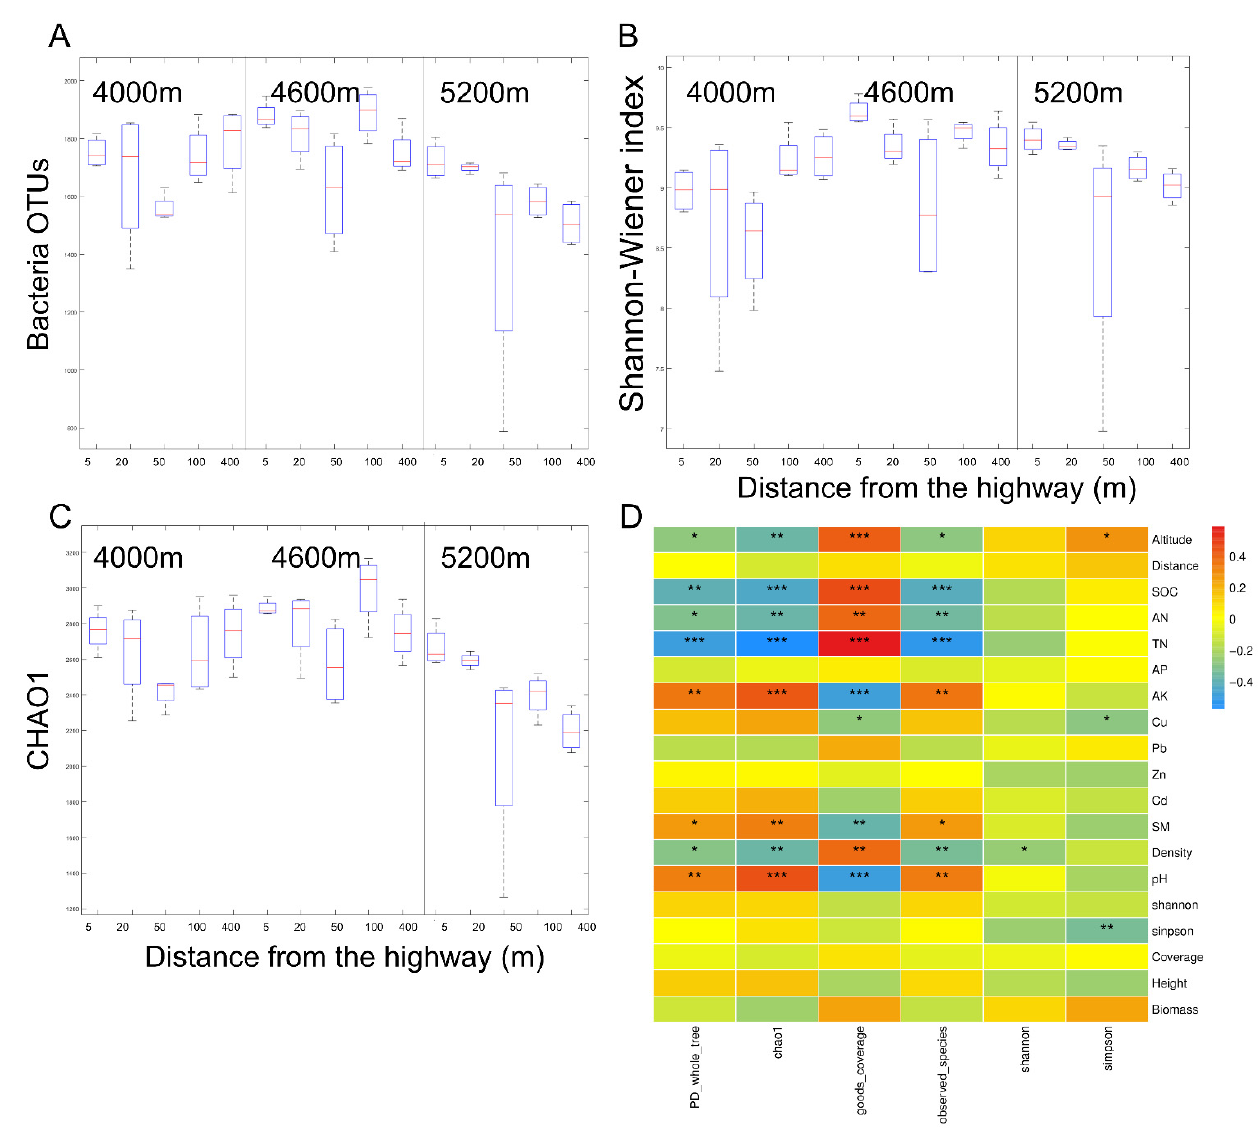
Figure 6. Box Diagram of ( A ) bacterial operational taxonomic unit (OTU), ( B ) bacterial Shannon and ( C ) bacterial CHAO1 in the 0–20 cm soil depths at 5, 20, 50, 100, and 400 m from G109 highway at altitudes of 4000 m (L), 4600 m, (M) and 5200 m (H). Pearson correlation heatmaps are based on bacterial alpha diversity estimators and environmental factors ( D ). * Means p < 0.05 for significance test; ** means p < 0.01 for significance test; *** means p < 0.001 for significance test.